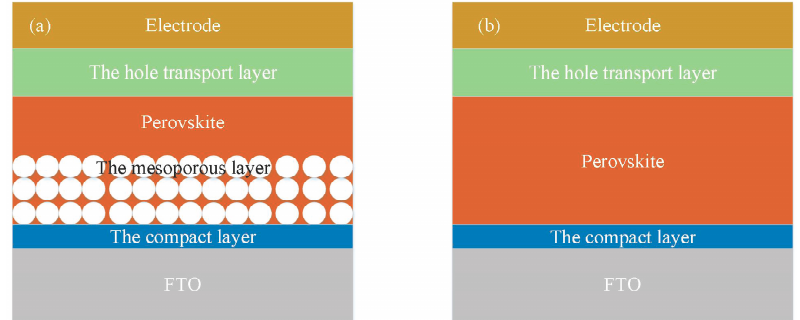
Figure 1. Structure of perovskite solar cells: ( a ) meso-porous structure; ( b ) planar pin junction structure.